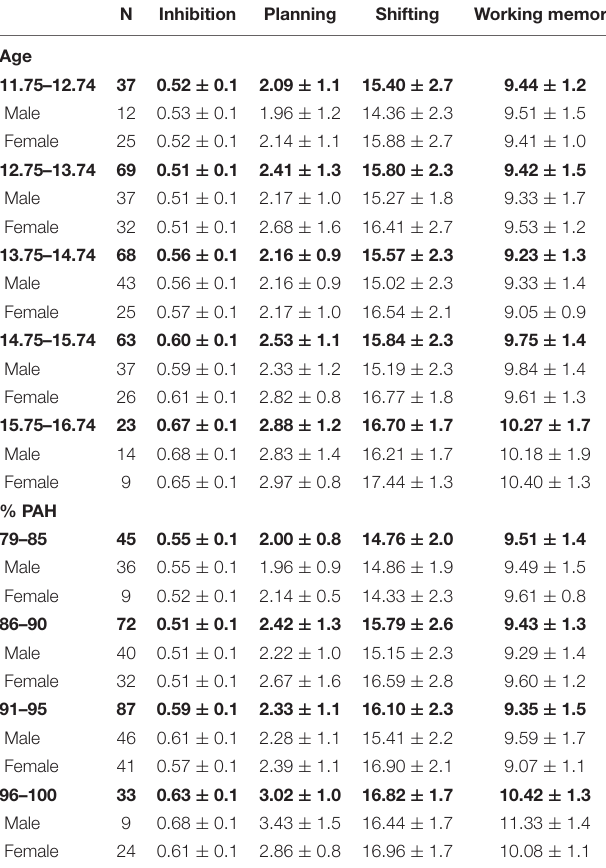
TABLE 1 | Number of participants (N) and means with standard deviation (M ± SD) of each EF component per sex and per age and %PAH. N Inhibition Planning Shifting Working memory